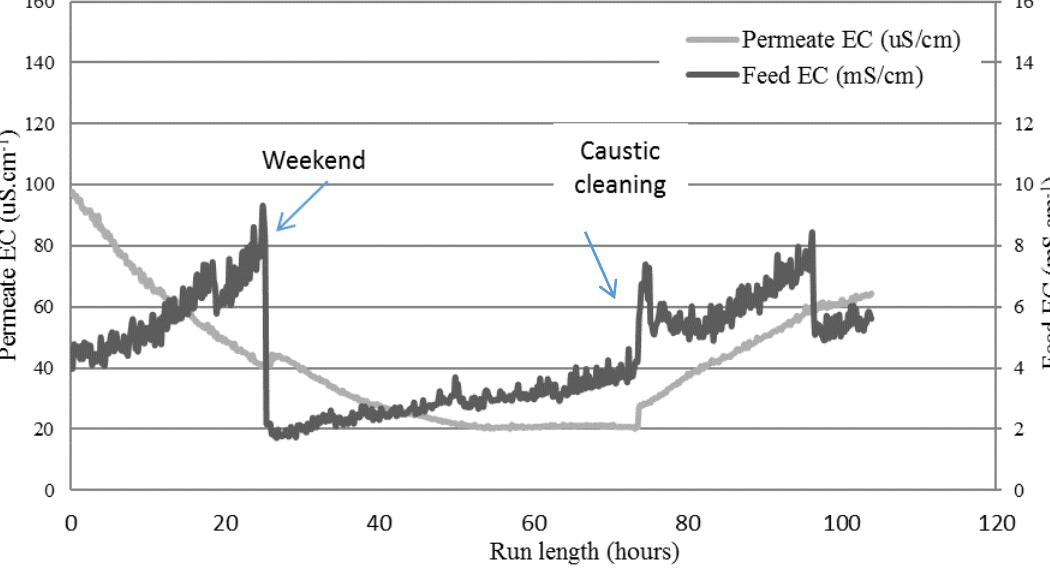
Figure 8. EC of the feed and permeate cycle containers while treating the textile wastewater on the hydrophilic-coated hydrophobic PTFE membrane. hydrophilic-coated hydrophobic PTFE